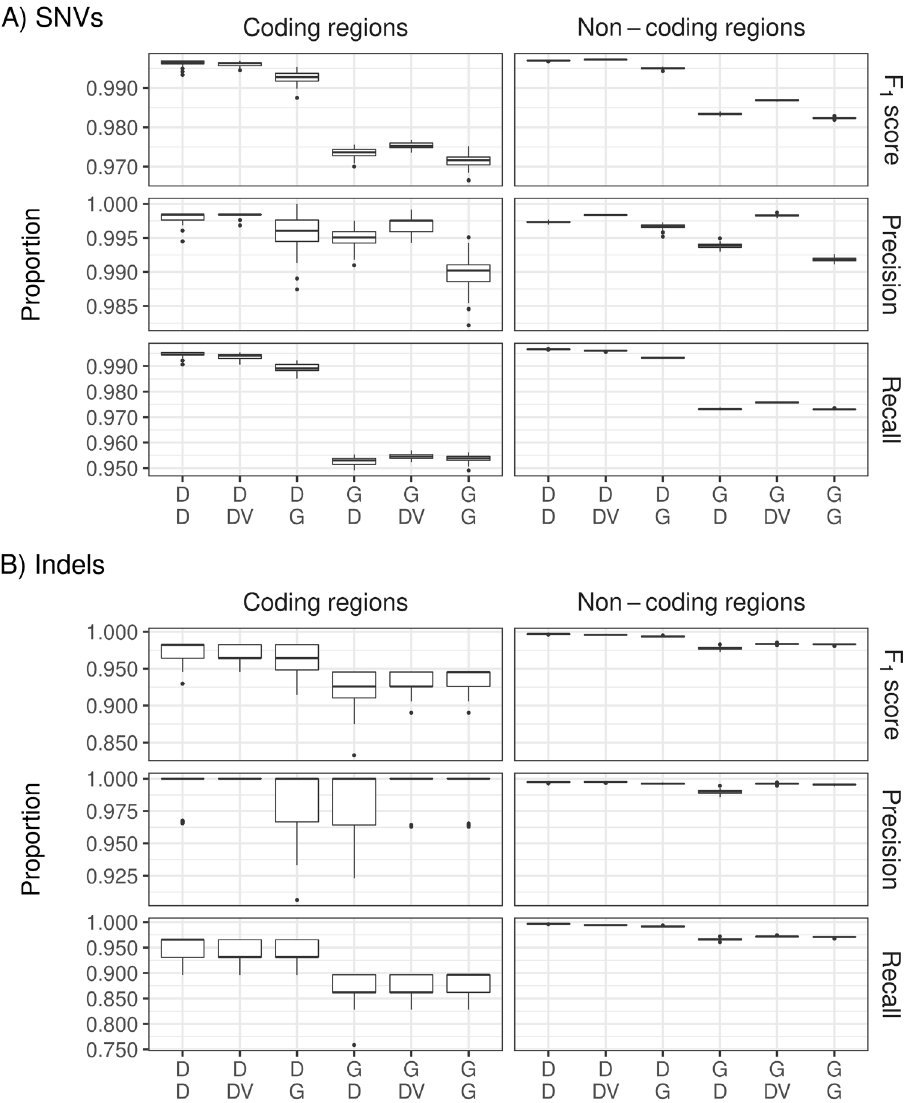
Figure 5. Percentages of F 1 score, precision, and recall for coding and non-coding regions for single nucleotide variation (SNV) (upper 6 panels) and Indels (lower 6 panels) for the 6 pipeline combinations, based on chromosomes 20–22 of the genome in a bottle sample HG003. Labels on the x-axis were defined in detail in Fig. 2. D DRAGEN, DV DeepVariant, G